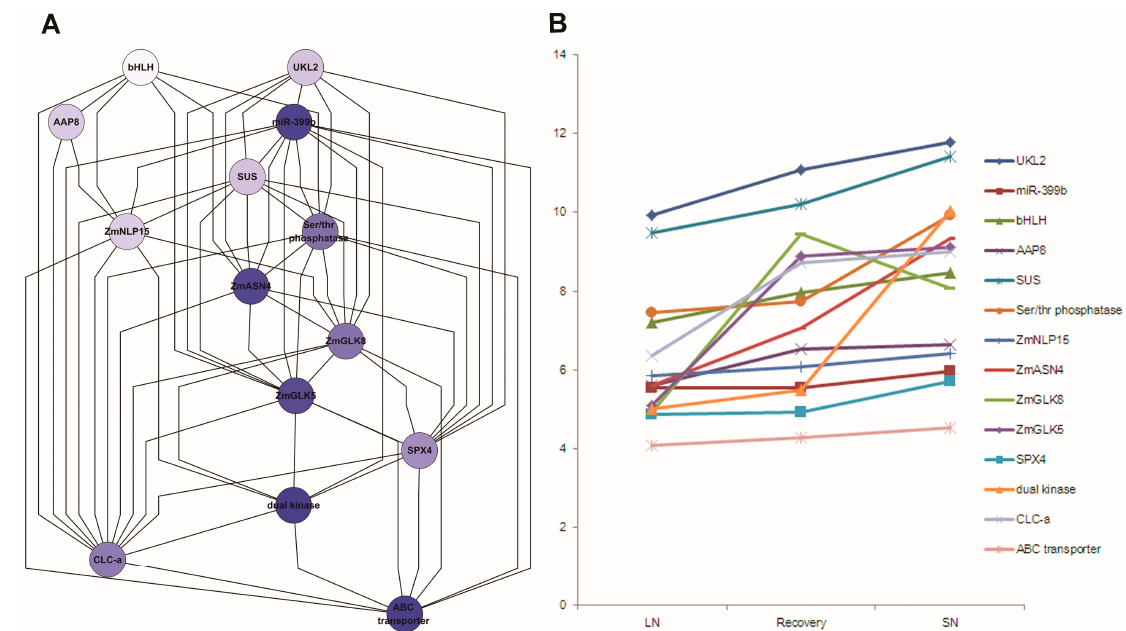
Figure 9. Subnetwork associated with N response genes ( A ); and their expression pattern ( B ) in maize